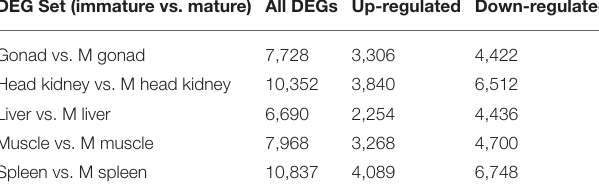
TABLE 3 | Statistics for DEGs of five tissues between of immature and mature Brachymystax lenok . DEG Set (immature vs. mature) All DEGs Up-regulated Down-regulated Gonad vs. M